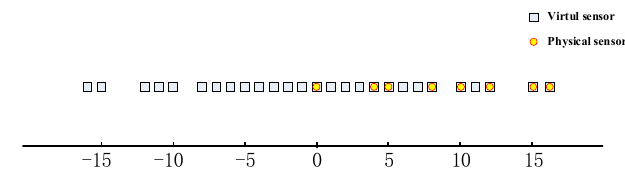
Figure 2. Geometry of coprime array.